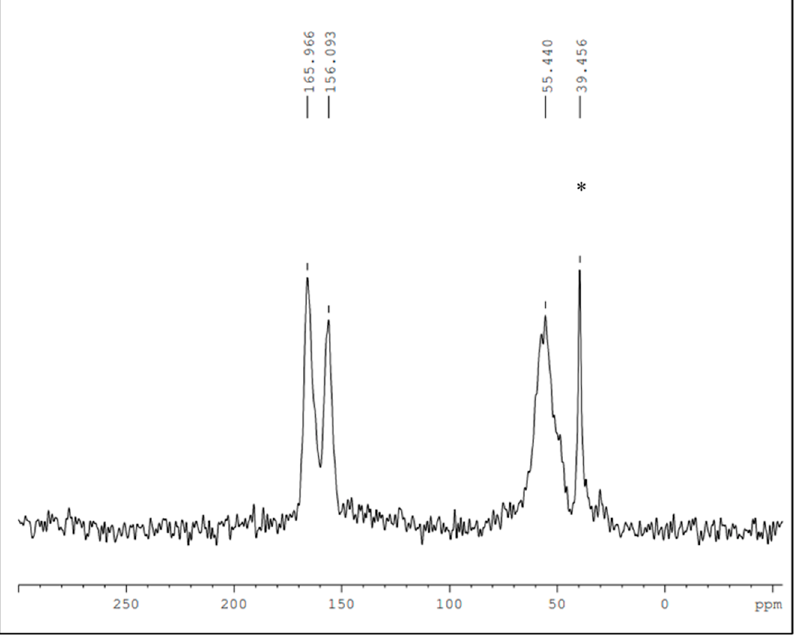
Figure 2. 13 C NMR spectrum of BiPy-PAN (*) peak arising from spinning sidebands.